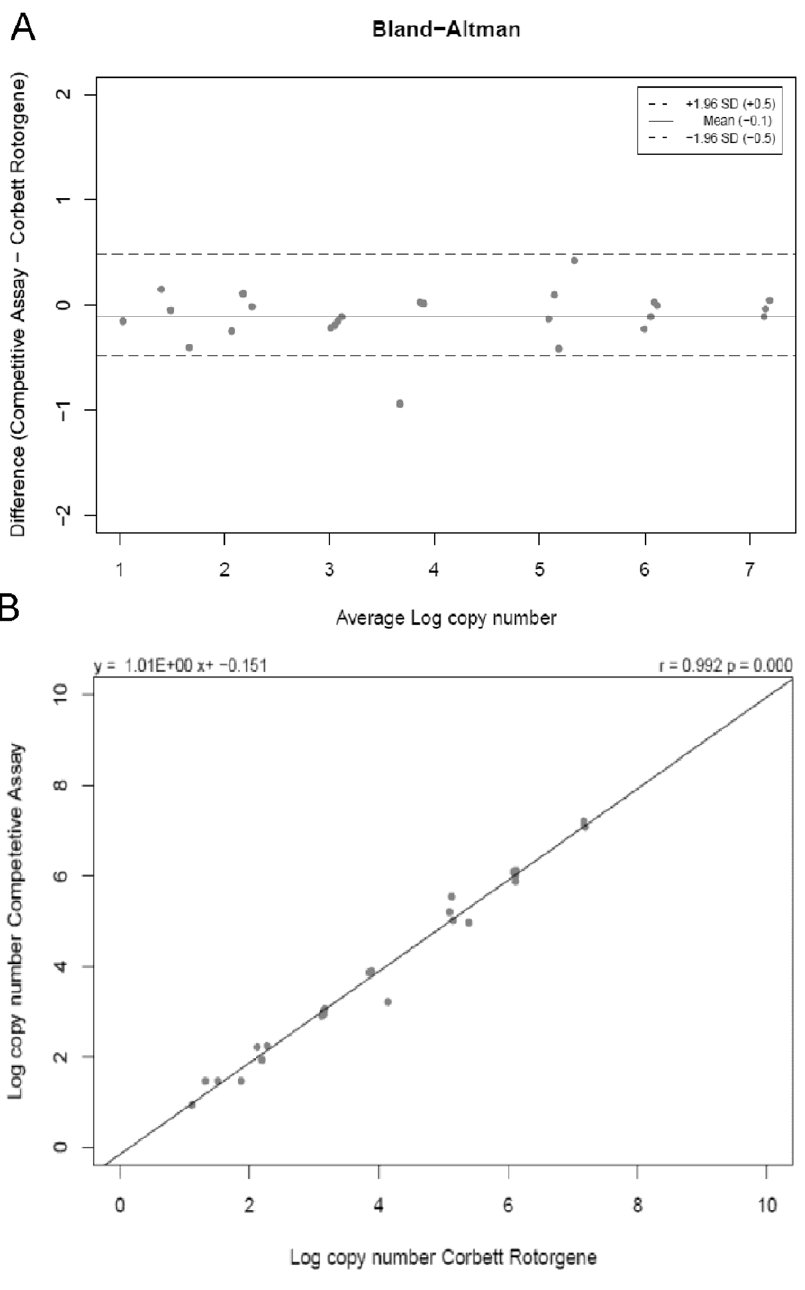
Figure 5. Bland- Altmann analysis of CMA and real time RT-PCR data. A. In order to analyse the agreement between competitive reporter monitored amplification CMA and conventional RT-PCR (the reference method), the respective data have been plotted by use of a Bland-Altman Plot. Methods have been found to be in good agreement with limits of agreement at + / 2 0.5 and a bias of 2 0.1. B. Log copy numbers of the reference method and the competitive assay calculated by their respective calibration curve are compared (n=25). A strong correlation between the two methods is observed (r=0.992, P , 0.001).